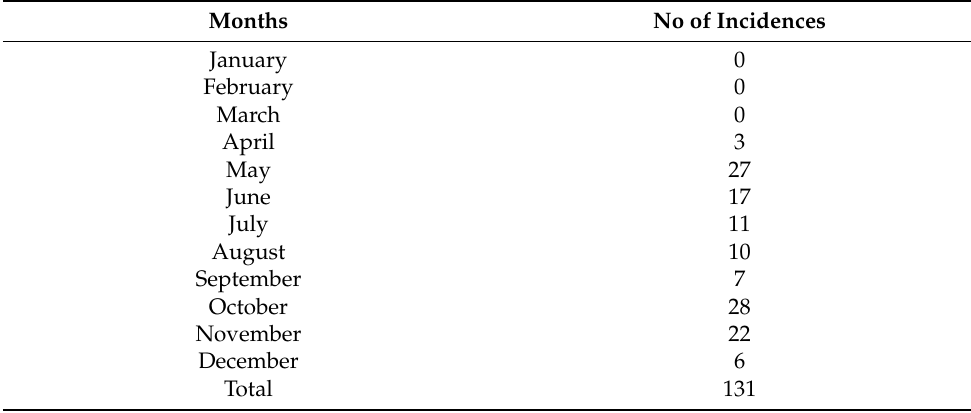
Table A4. Frequency of Landfalling Cyclones of Bangladesh